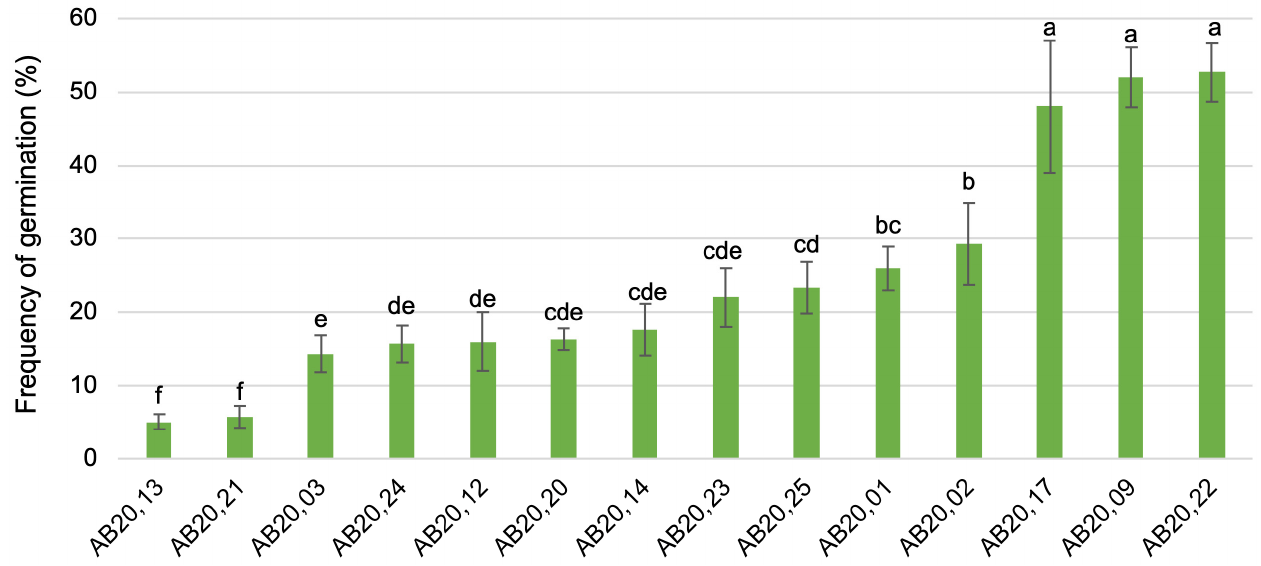
Figure 2. Data on seed germination frequency for different crosses of raspberry following the scarification and stratification method. Results are expressed as the (number of germinated seeds/total scarified seeds) × 100 at 3 months after sowing. One-way ANOVA was used to analyze the data. Different letters show significant differences at p < 0.05 by Duncan’s test (n = 100). Each value represents the mean ± standard deviation of three independent experiments.